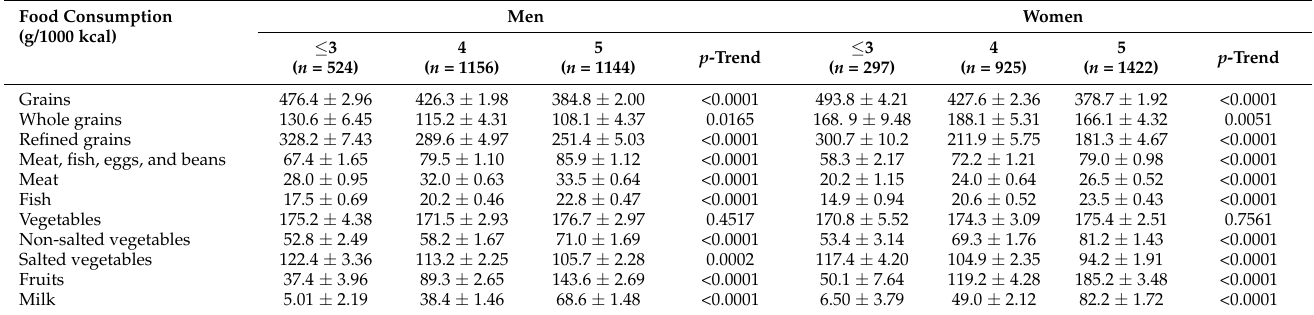
Table 2. Food consumption according to dietary diversity score.